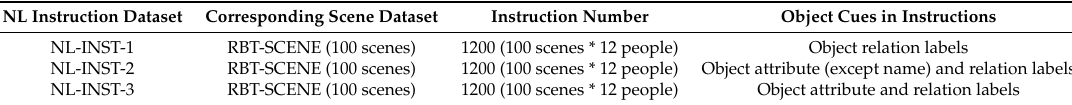
Figure 6. Example objects in our collected RGB-D object dataset. Table 2. NL instruction dataset characteristics.